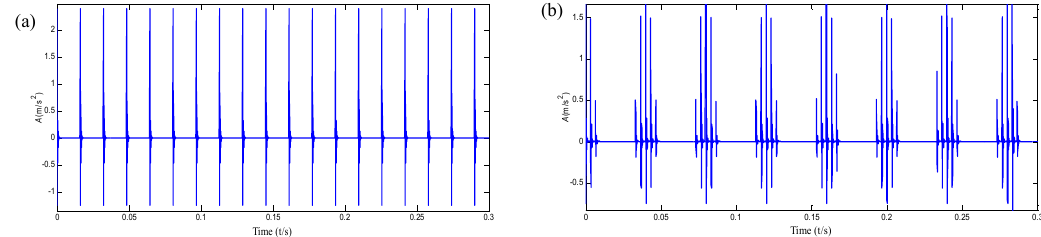
Figure 6. The time-domain waveform of the single fault simulation signal: ( a ) Outer race; ( b ) Inner race.